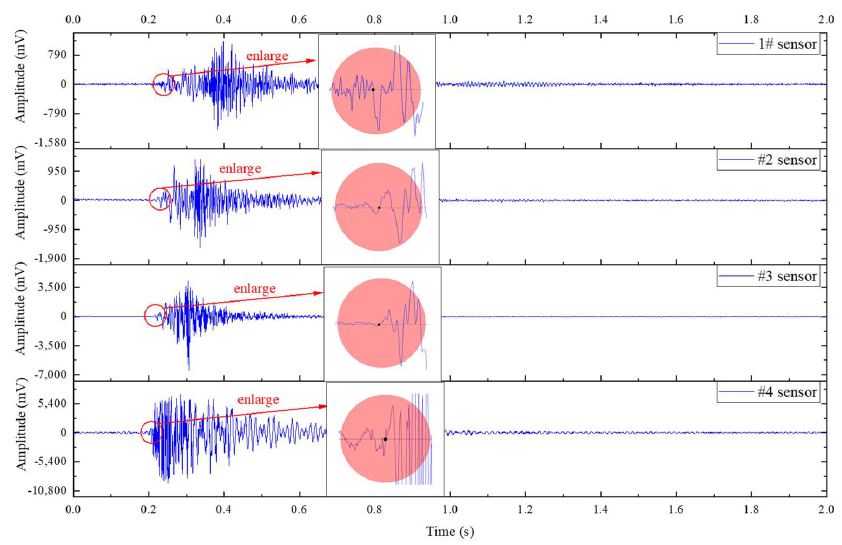
Figure 3. A case event waveform to show magnitude sequencing and arrival time sequencing.